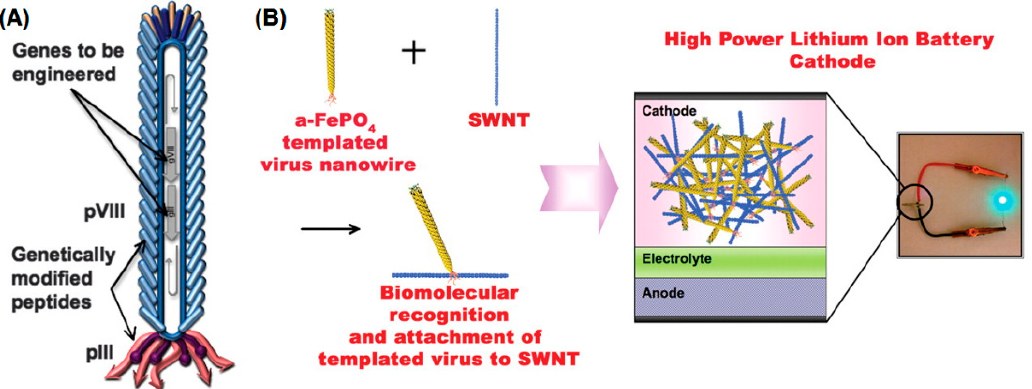
Figure 4. Genetically engineered M13 bacteriophage used as a lithium-ion battery cathode. ( A ) The gene VIII protein (pVIII), a major capsid protein of the virus, is modified to serve as a template for amorphous anhydrous iron phosphate (a-FePO 4 ) growth. The gene III protein (pIII) is also engineered to have a binding a ffi nity for single-walled nanotubes (SWNTs). ( B ) The fabrication of genetically engineered high-power lithium-ion battery cathodes and a photograph of the battery used to power a green light-emitting diode (LED). (Reprinted with permission from Lee et al. Science 324 , 1051–1055 (2009) [86]).